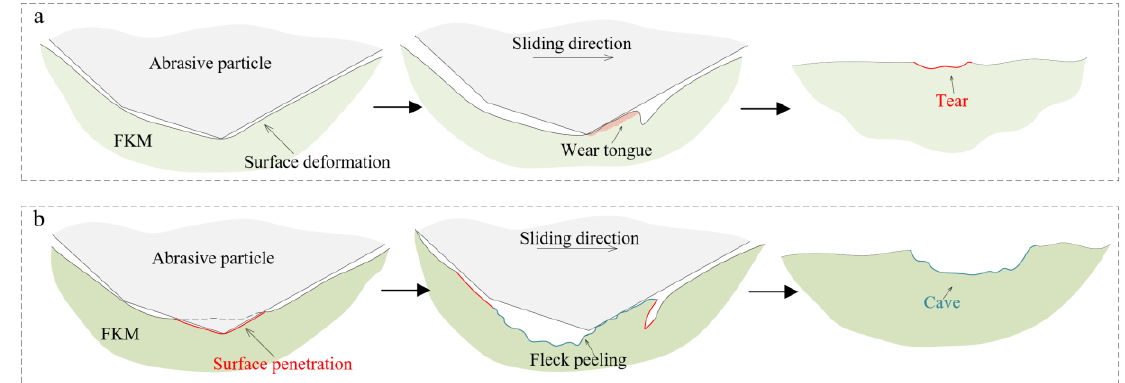
Figure 9. Wear mechanisms of ( a ) surface tear and ( b ) abrasion cave.